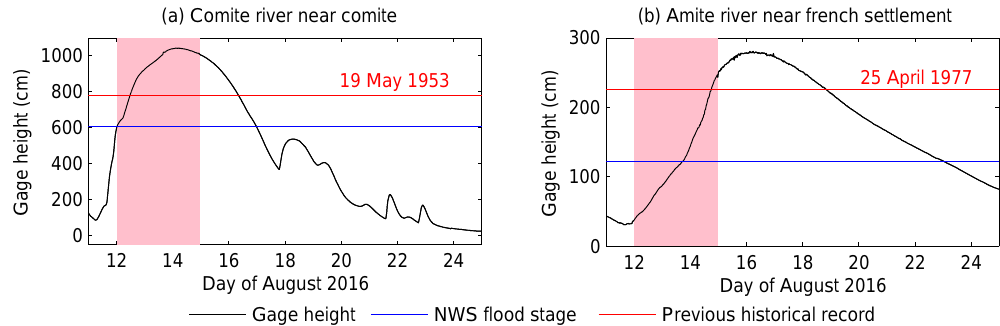
Figure 2. Hydrographs of gauge levels, NWS flood stage value and previous historical record for USGS station (a) 07378000 on the Comite River and (b) 07380200 on the Amite River. Shaded pink areas indicate the 3-day period of maximum precipitation (12–14 August 2016). Observed stream gauge information was downloaded 25 August 2016 from the USGS: http://waterdata.usgs.gov/la/nwis/uv?; provisional USGS data are subject to adjustment: